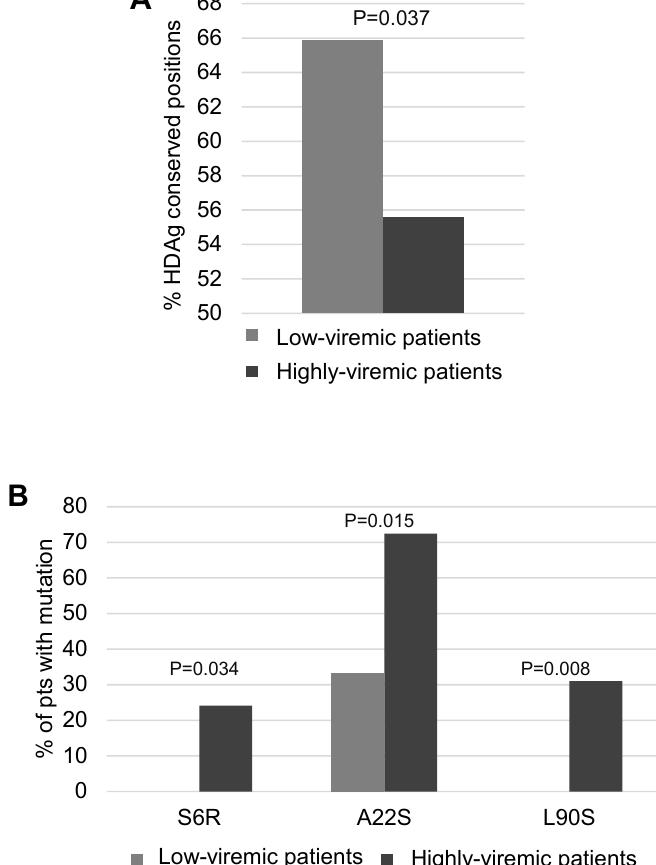
Figure 6. Association of mutated positions in HDAg with levels of HDV-RNA. ( A ) The histogram reports the percentage of conserved HDAg positions in patients with serum HDV-RNA <5 log IU/mL ( n = 18) and in patients with serum HDV-RNA >5 log IU/mL ( n = 29). ( B ) The histogram reports the percentage of patients with HDAg mutations S6R, A22S, and L90S calculated in patients with serum HDV-RNA <5 log IU/mL ( n = 18) and in patients with serum HDV-RNA >5 log IU/mL ( n = 29). Statistically significant difference was assessed by Chi Squared Test based on a 2 × 2 contingency